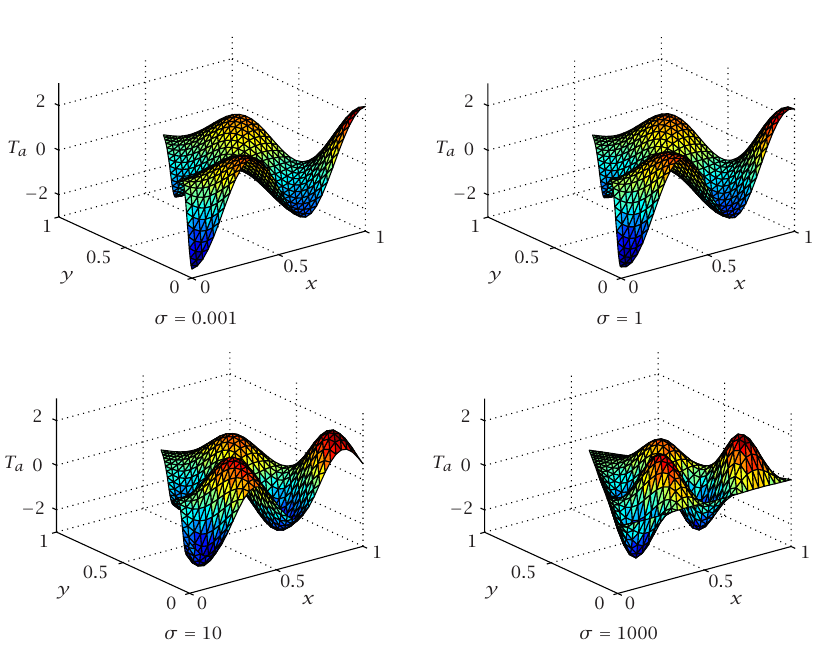
Figure 7.5 . The ( 1 , 2 ) antisymmetric